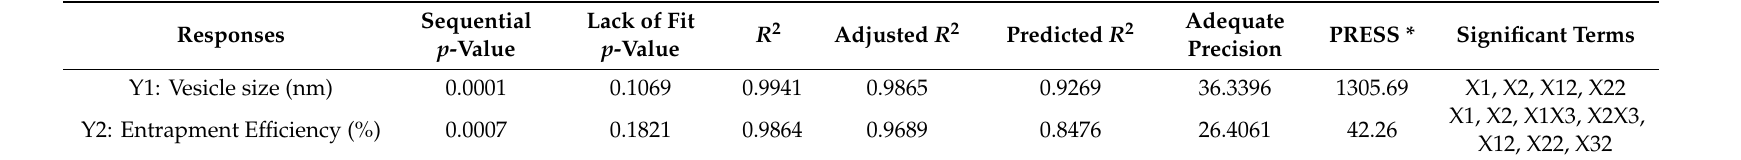
Table 4. Quadratic model statistics of PIC-E